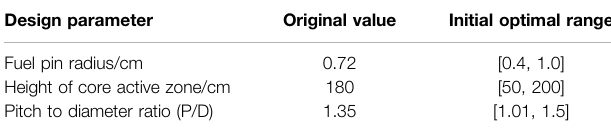
TABLE 6 | Original value and initial optimal range of design parameters for